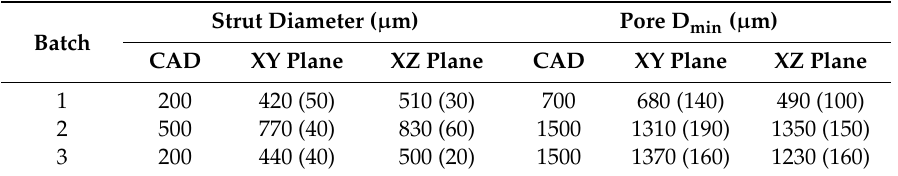
Table 2. Strut and pore size: Comparison between CAD and experimental values. Standard deviation in parentheses.